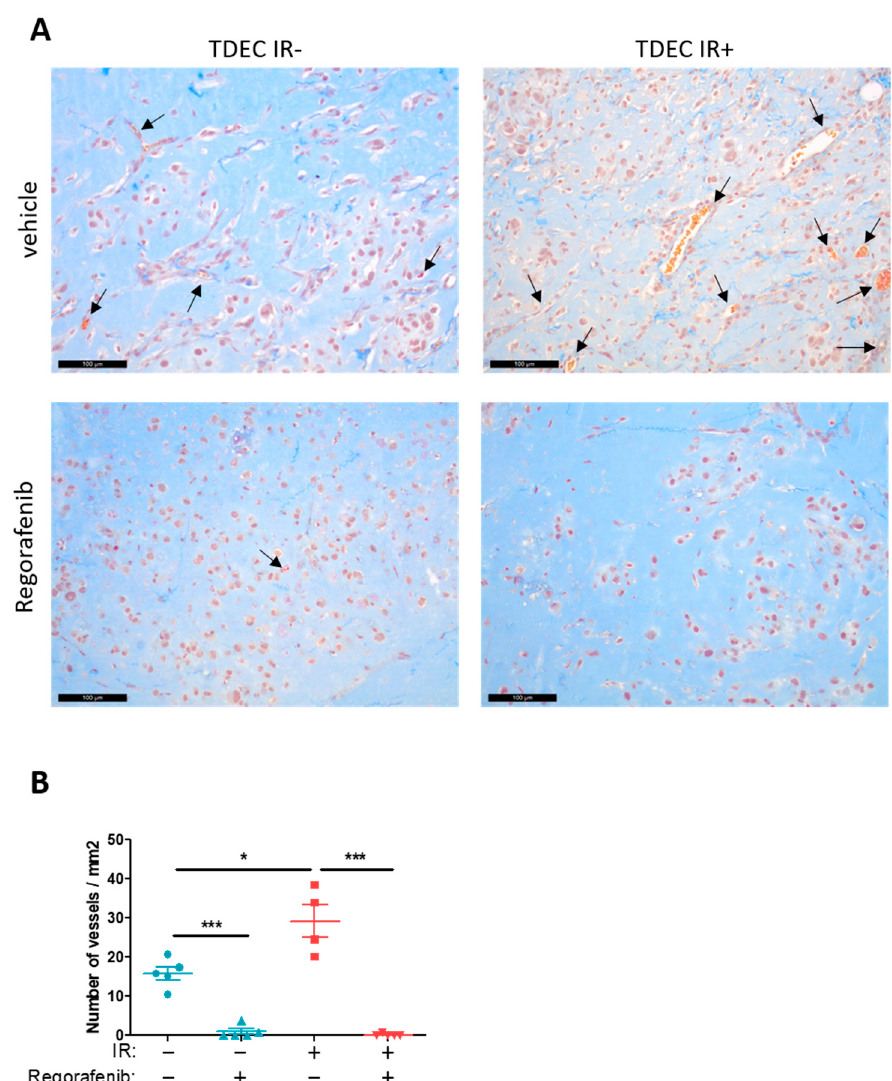
Figure 6. Regorafenib inhibits GSC-mediated conventional and irradiation-induced transdifferentiation in vivo. Matrigel TM plug assay. ( A ) Representative trichrome Masson sections of Matrigel plugs with TDEC obtained from non-irradiated GC1 (left photos) or irradiated GC1 (right photos) with (lower panel) or without (upper panel) regorafenib. The black arrows indicate functional blood vessels. Scale bars, 100 µ m. ( B ) Quantification of functional blood vessels in Matrigel TM plugs/mm 2 . The number of vessels/mm 2 was expressed as the mean ± SEM of 5 mice for untreated TDEC IR-, TDEC IR- treated with regorafenib and TDEC IR+ treated with regorafenib and of 4 untreated TDEC IR+ mice; * p < 0.05; *** p < 0.001.